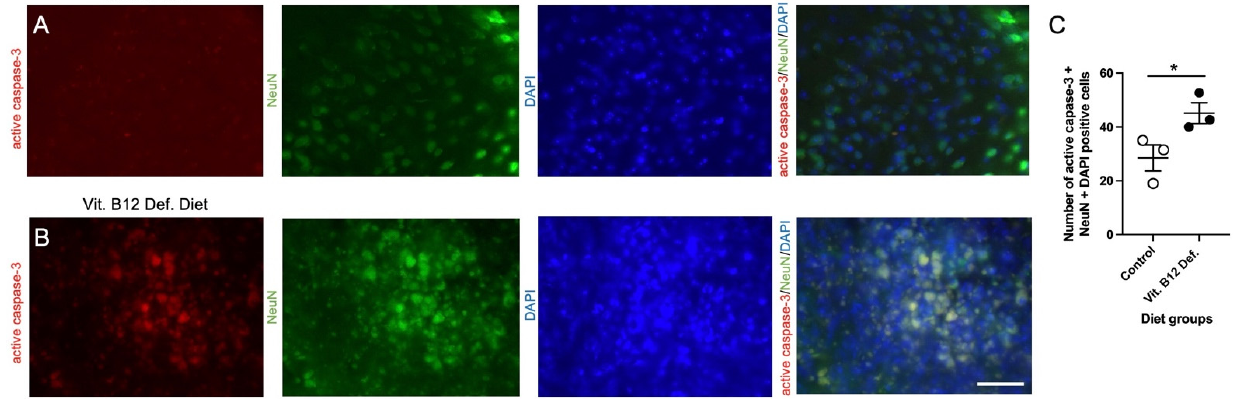
Figure 3. Impact of dietary vitamin B12 deficiency (vit. B12 def.) and ischemic stroke on neuronal active caspase-3 cell counts. Representative images of immunofluorescence staining with positive semi-quantitative spatial colocalization of active caspase-3 with neuronal nuclei (NeuN) and 4 ′ ,6-diamidino-2-phenylindole (DAPI) from control ( A ) and vit. B12 def. ( B ) diets. Quantification of active capsapse-3, NeuN, and DAPI cell counts ( C ). Depicted are means of ± SEM of three mice per group. Scale bar = 50 µ m. * p < 0.05, un-paired t -test.